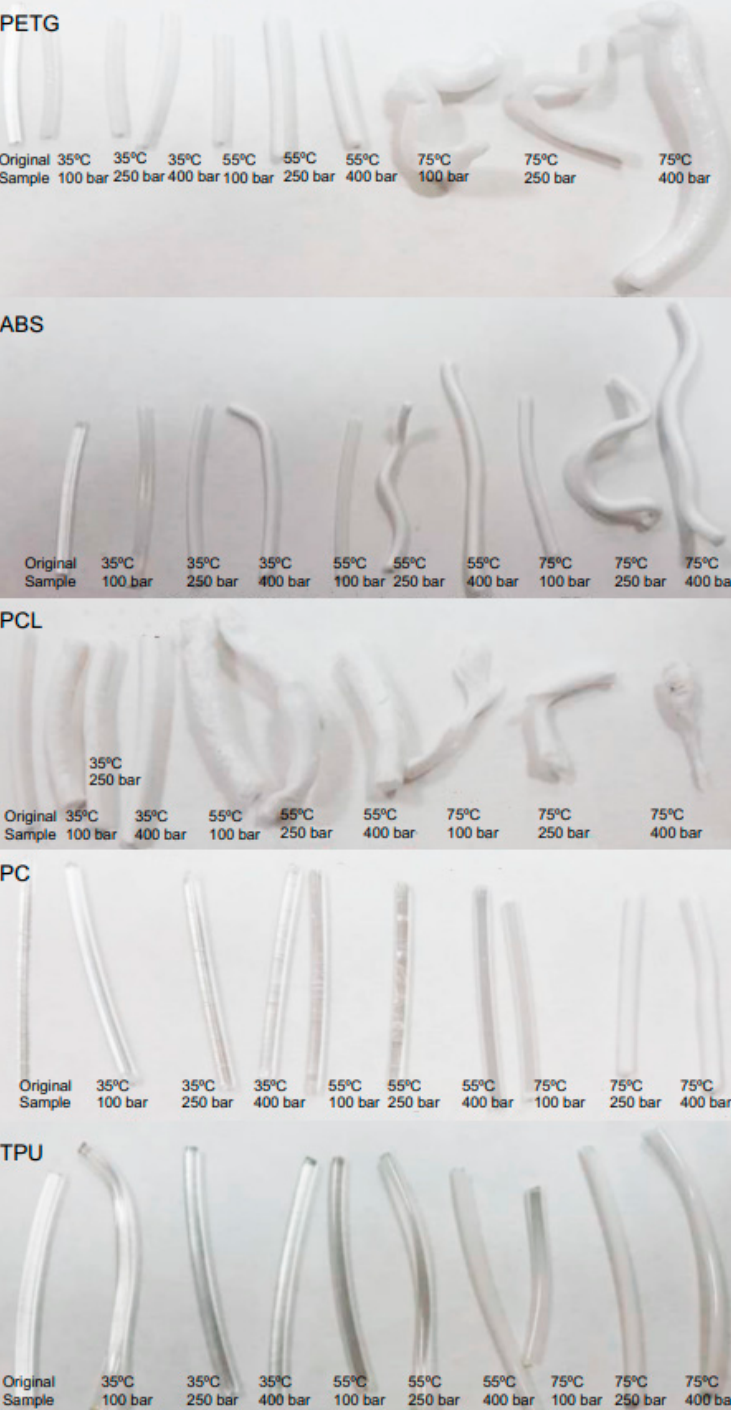
Figure 2. Picture of the polymers under different supercritical conditions.